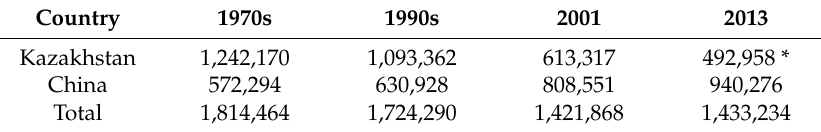
Table 2. Agricultural land (ha) in the Ili river basin from 1970s to 2013 [50]. Country